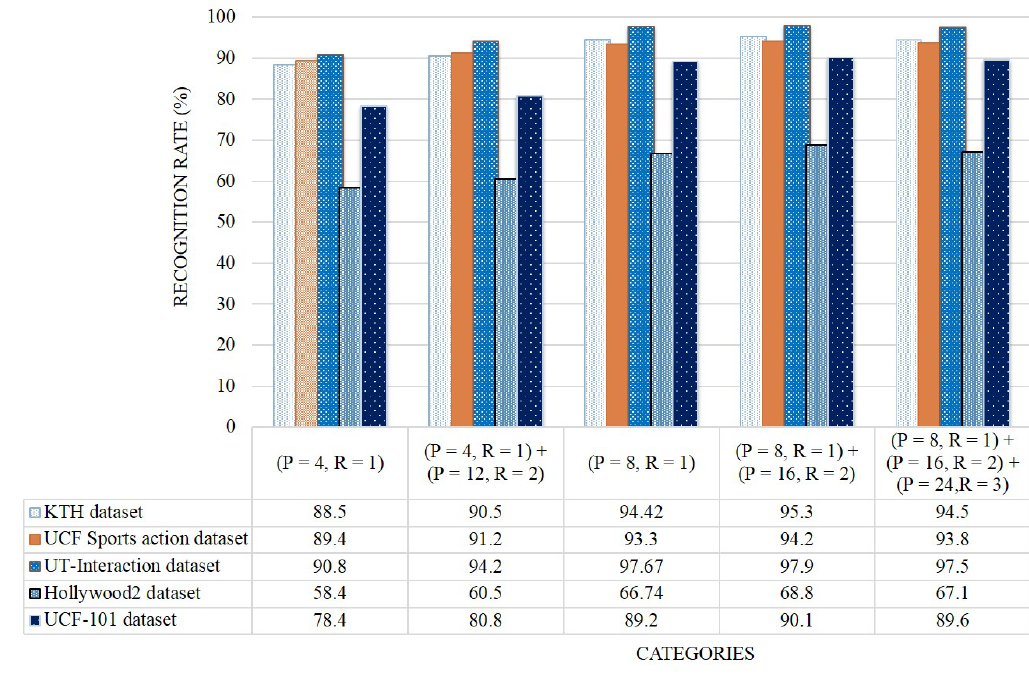
Figure 17. Classification accuracy (%) of WVLGTP with multi-resolution approach on all five datasets.